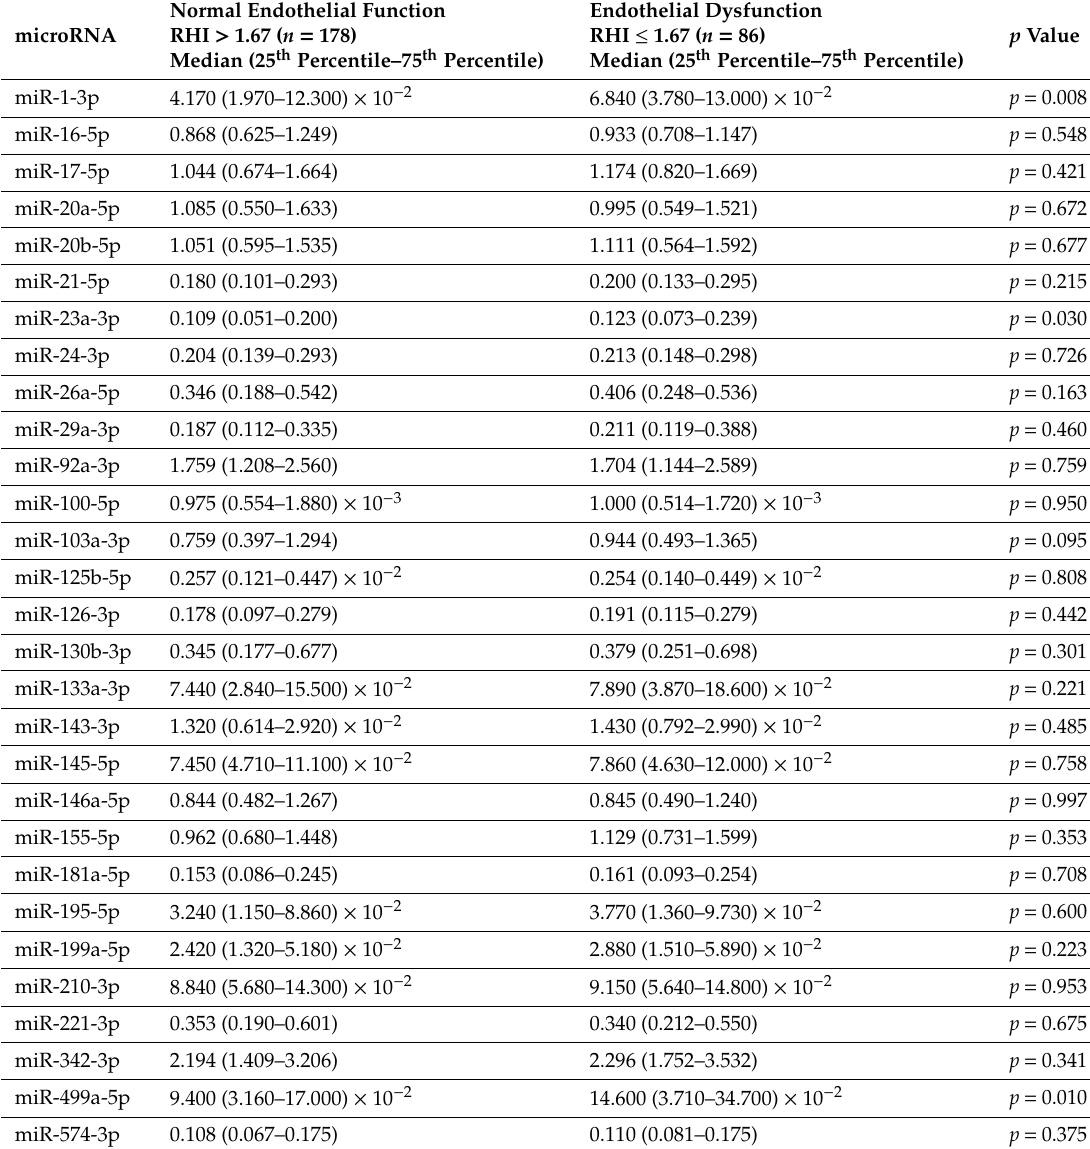
Table 6. Association between the occurrence of vascular endothelial dysfunction and the expression of cardiovascular and cerebrovascular disease associated microRNAs in whole peripheral blood of young and middle-aged women_ overview (Mann-Whitney U test